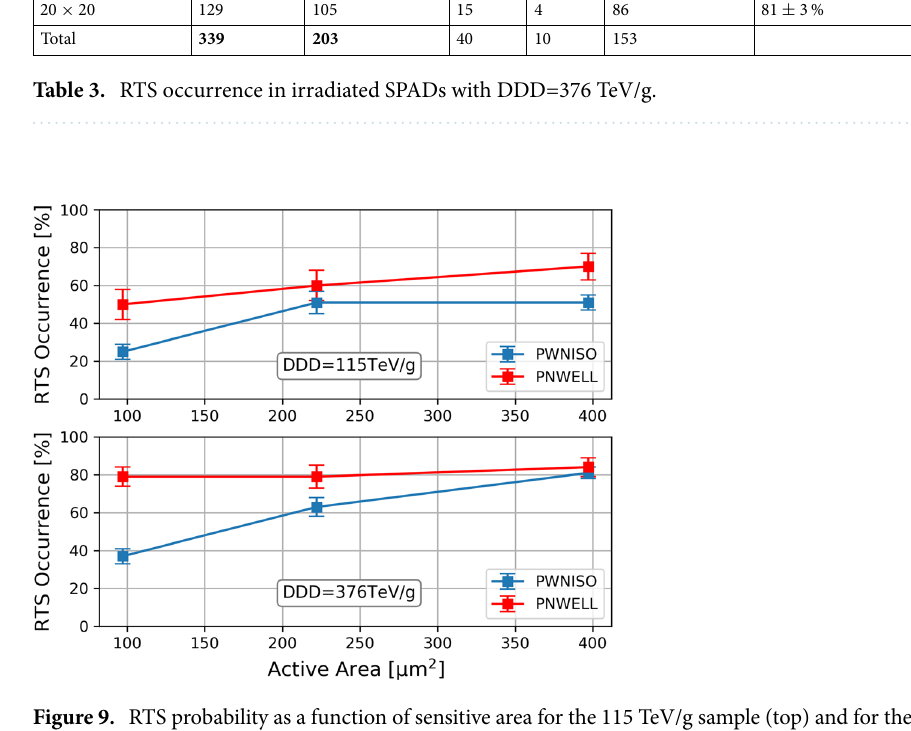
Figure 9. RTS probability as a function of sensitive area for the 115 TeV/g sample (top) and for the 376 TeV/g sample